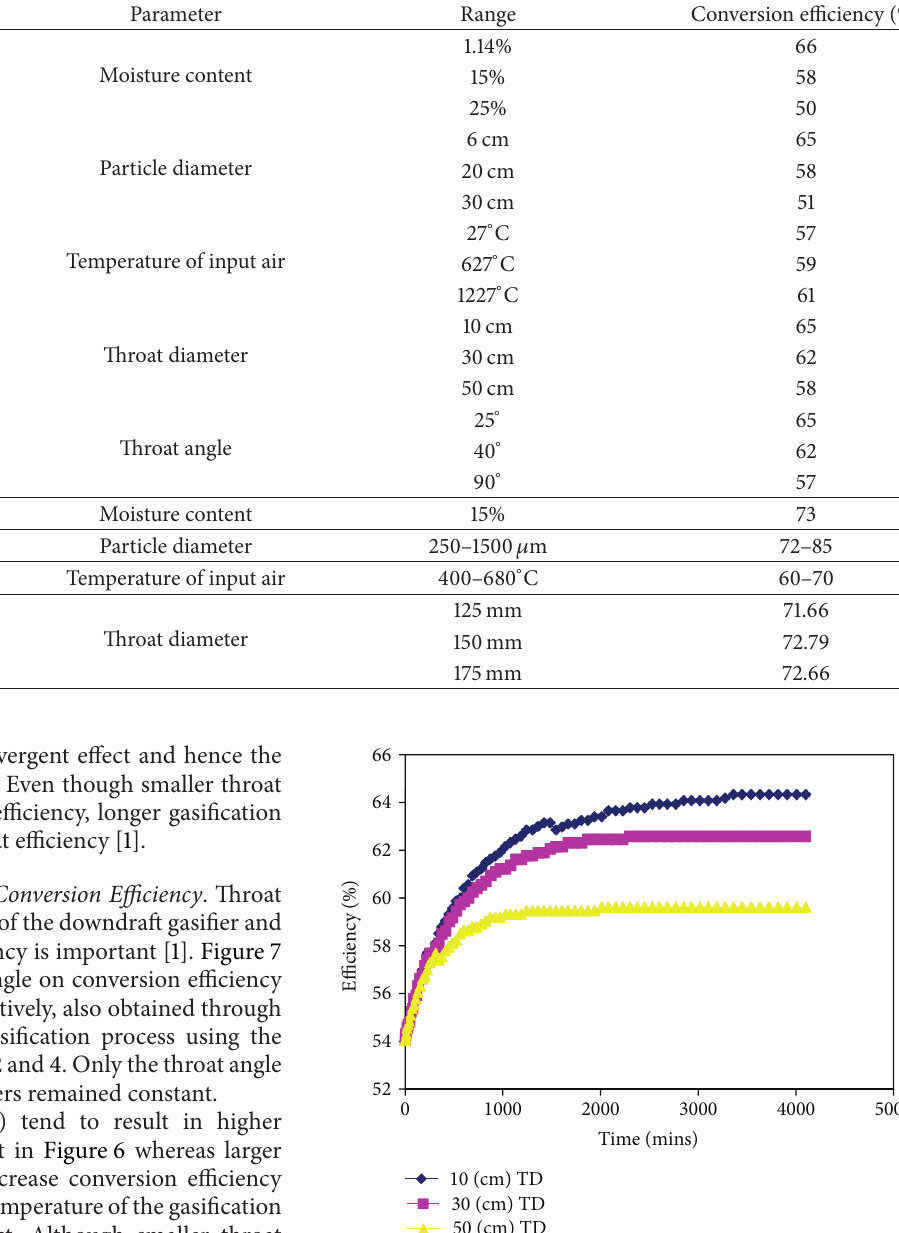
Table 5: A comparison of the simulated results from this study with experimental data from the literature.